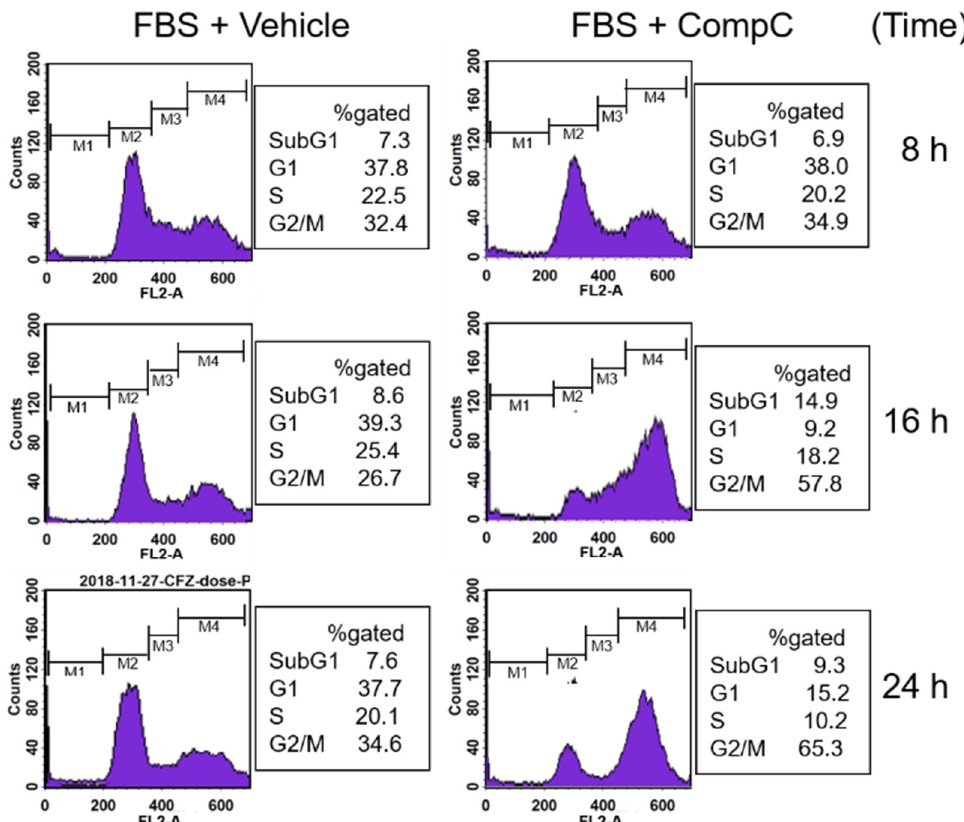
Figure 2. CompC treatment resulted in G2/M cell cycle arrest. Renca cells were seeded onto 6-well plates, cultured for one day and serum-depleted by incubation with serum free medium (SFM) overnight. Cells were pre-treated with the vehicle or 10 µ M CompC for 1 h and then stimulated with 10% fetal bovine serum (FBS) for the indicated times. The DNA content was evaluated by flow cytometry after staining the nuclei with propidium idodide (PI). The percentage of cells in each phase is shown on the right.